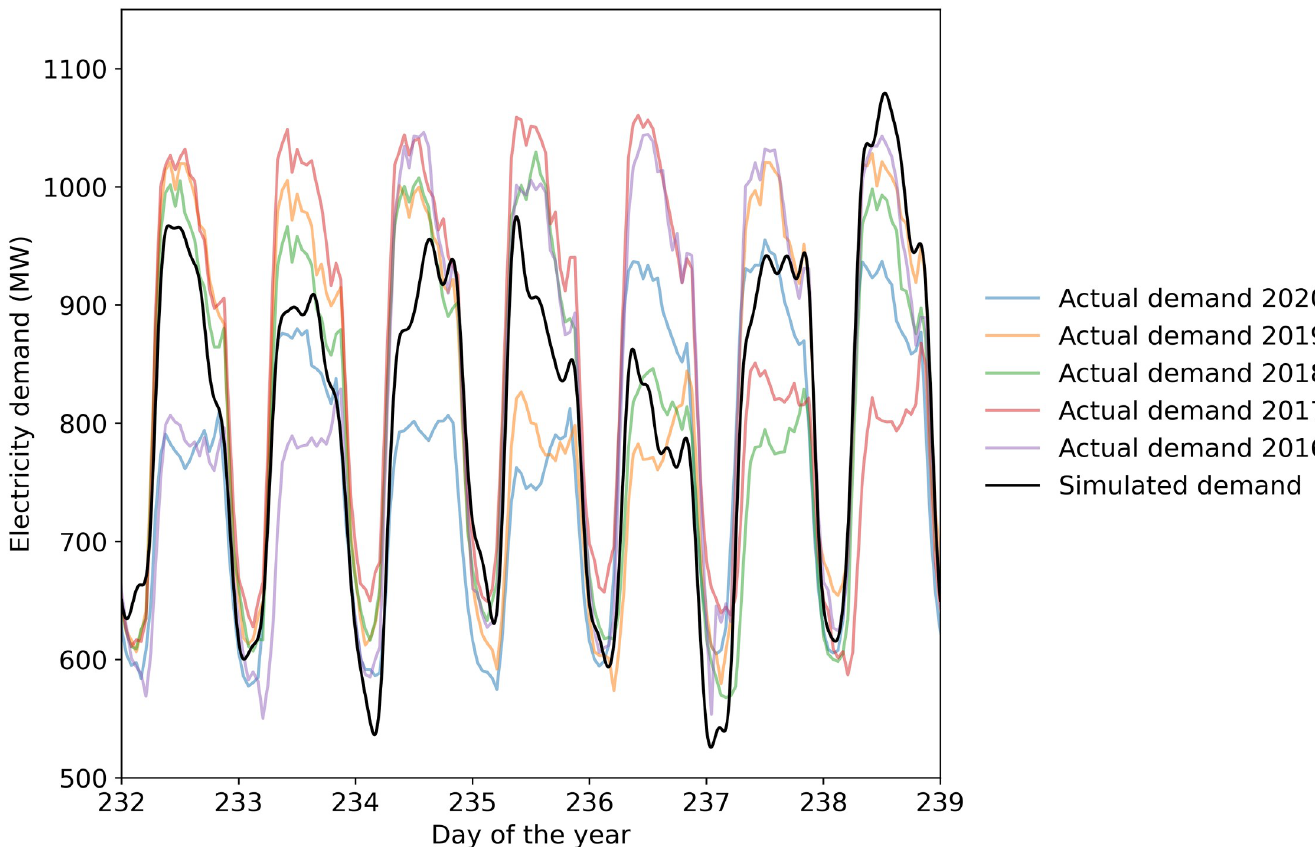
Fig 2. Comparison of actual demand data and one example of generated demand data.